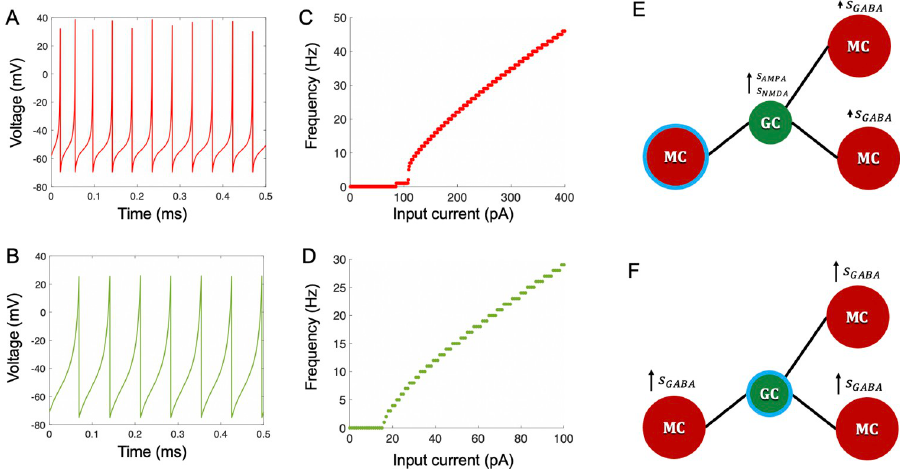
Fig 2. Cell dynamics modeling. ( A ) Sample voltage trace of an MC. Input was 200 pA direct current. ( B ) Sample voltage trace of a GC. Input was 45 pA direct current ( C ) Frequency-current (f-I) curve for an MC. ( D ) f-I curve for a GC. Each cell in ( C ) and ( D ) was simulated with the given parameters in Table 1, receiving direct current for 1 second of in-simulation time per current intensity. ( E ) When an MC spikes (MC with blue ring), gating variables of GC AMPA and NMDA receptors increase at synapses between that MC and all connected GCs. In turn, gating variables of MC GABA receptors increase by a smaller amount at synapses between connected GCs and their subsequent connected MCs ( F ) When a GC spikes (GC with blue ring), gating variables of MC GABA receptors increase at synapses between that GC and all connected